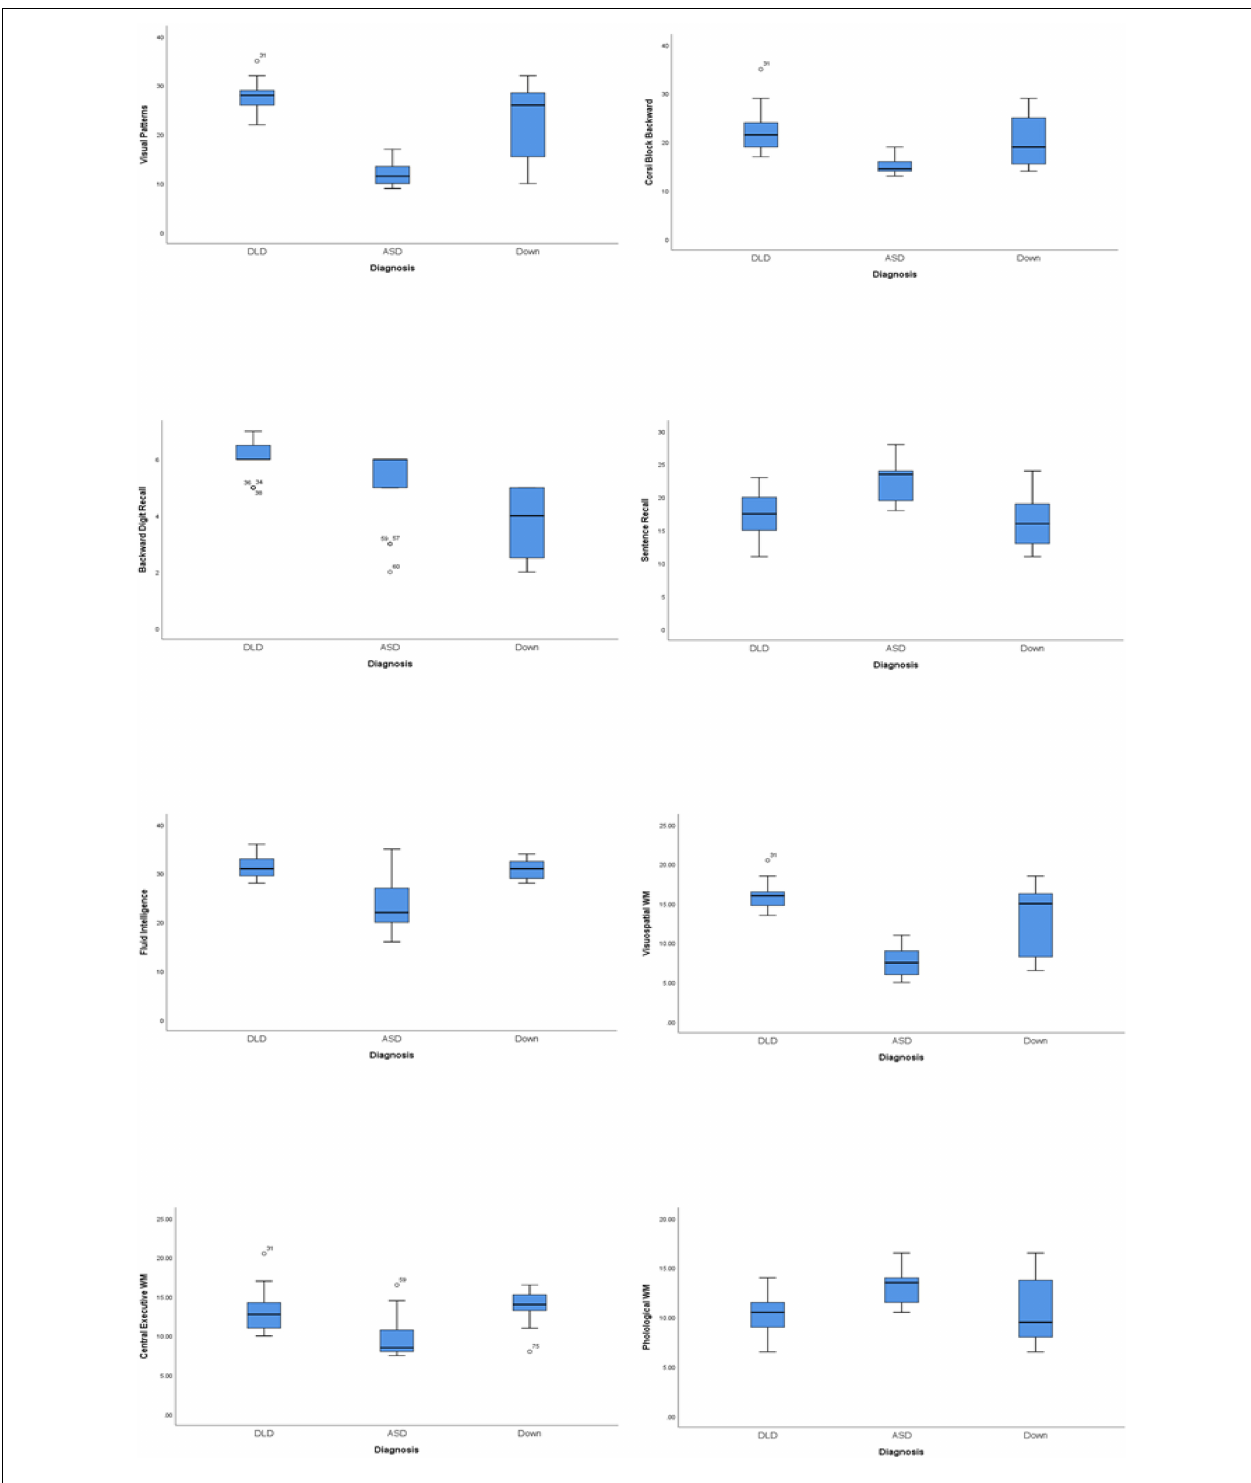
FIGURE 1 | Boxplots for the graphically presentation of the differences for the fluid intelligence, the phonological working memory tasks, the visuo-spatial working memory measures, and the three general working memory variables central executive, phonological working memory, and visuo-spatial working memory among the three